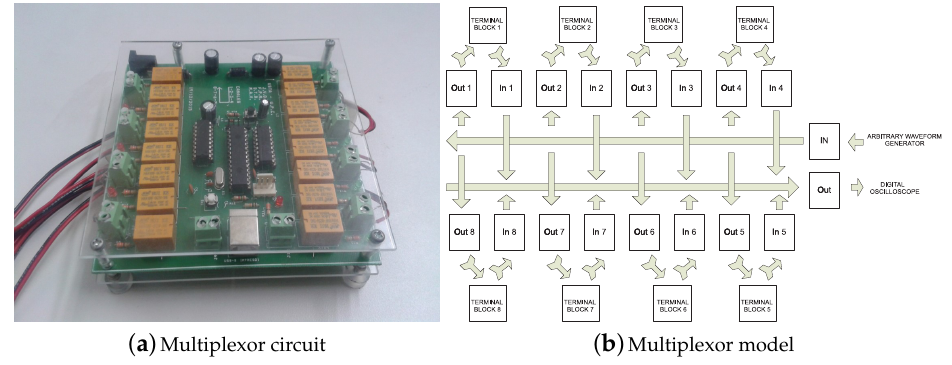
Figure 5. Multiplexor system used in the data acquisition